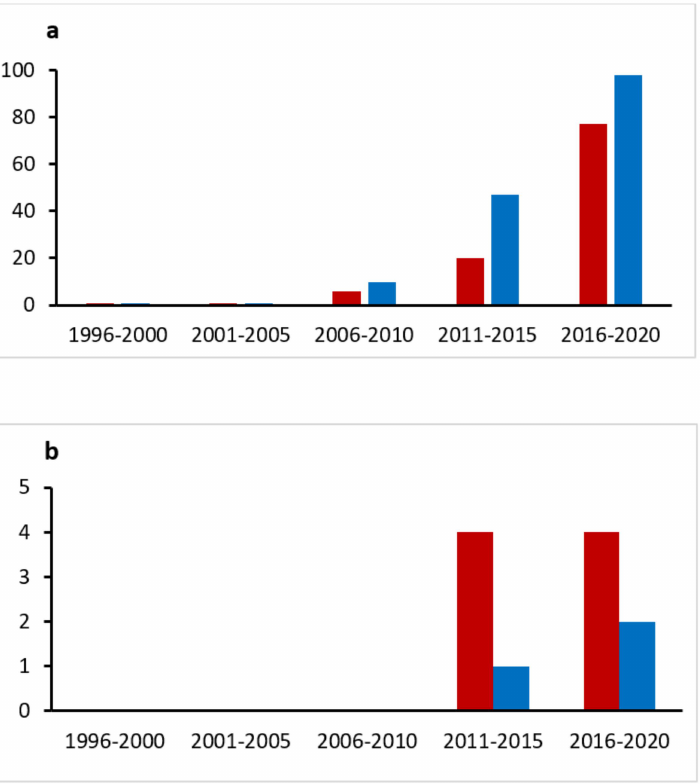
Figure 1. Graphs representing the publications found by combining the term lactoferrin with ( a ): nanoparticles, microparticles or encapsulation; ( b ): edible films, active films or active packaging, in PubMed (blue bars) and ScienceDirect (red bars) shown with